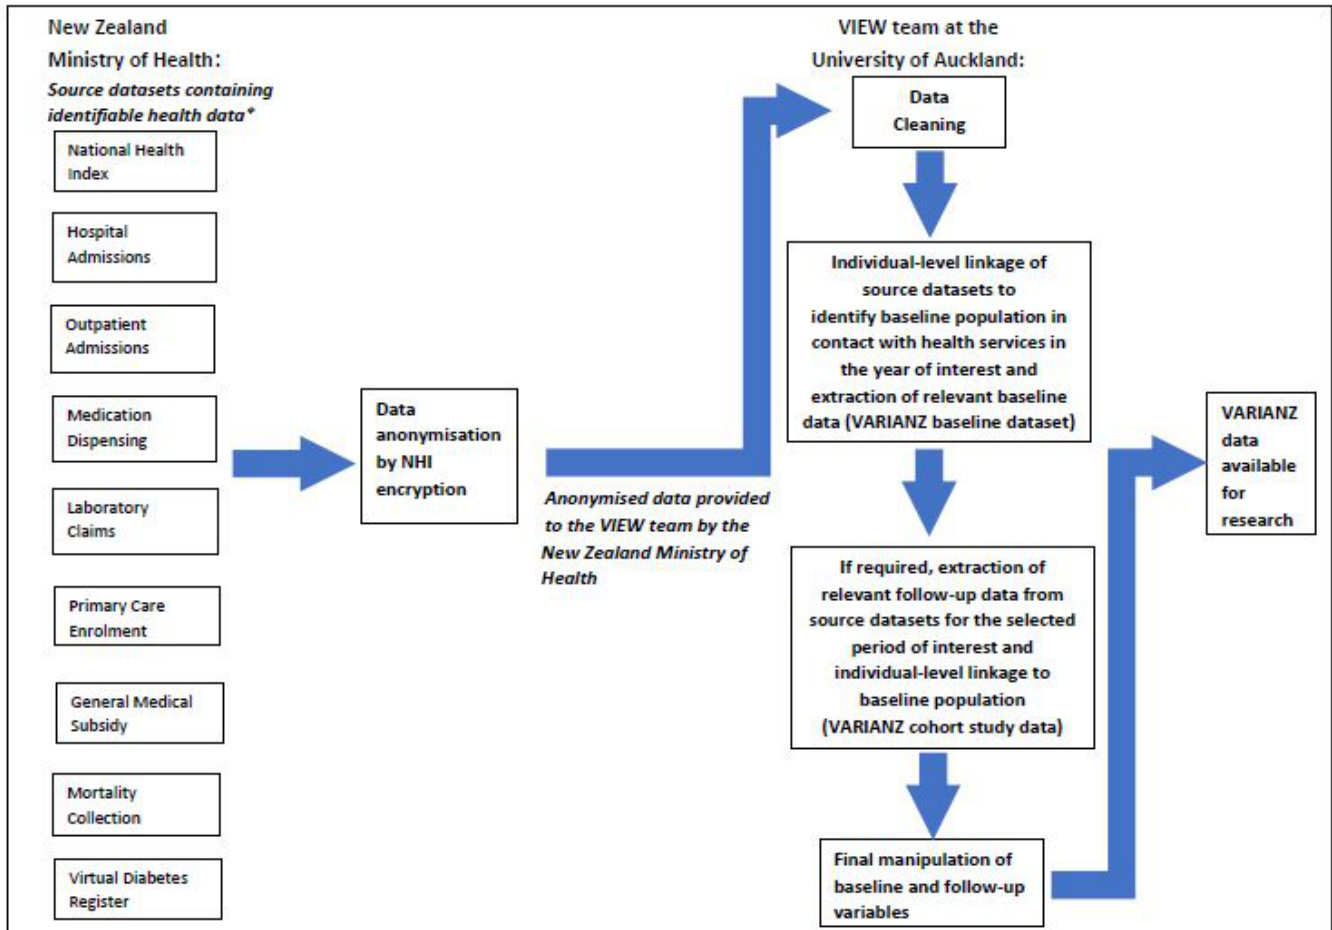
Figure 1: Overview of the process to construct VARIANZ data resources available for research